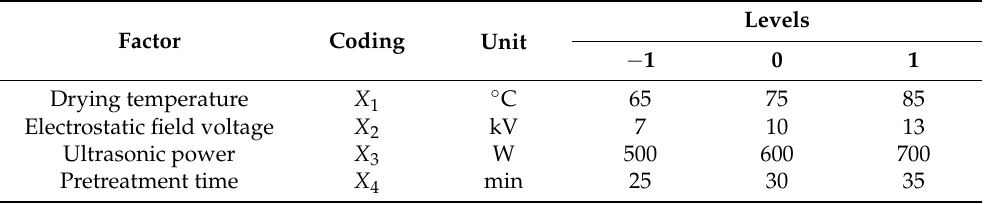
Table 1. Coded and uncoded values of variables and their levels.